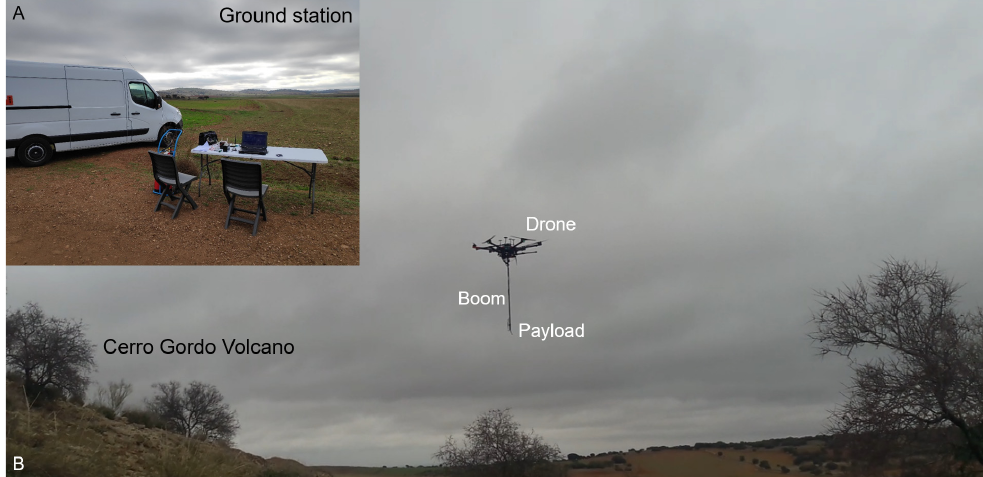
Figure 3. ( A ) Ground station. ( B ) Drone with the boom to deploy the magnetometer in flight con- figuration. During the take-off and landing, the boom is held horizontally by a servo, and during the flight, the boom is in a vertical position (Figures 3B and 4A).